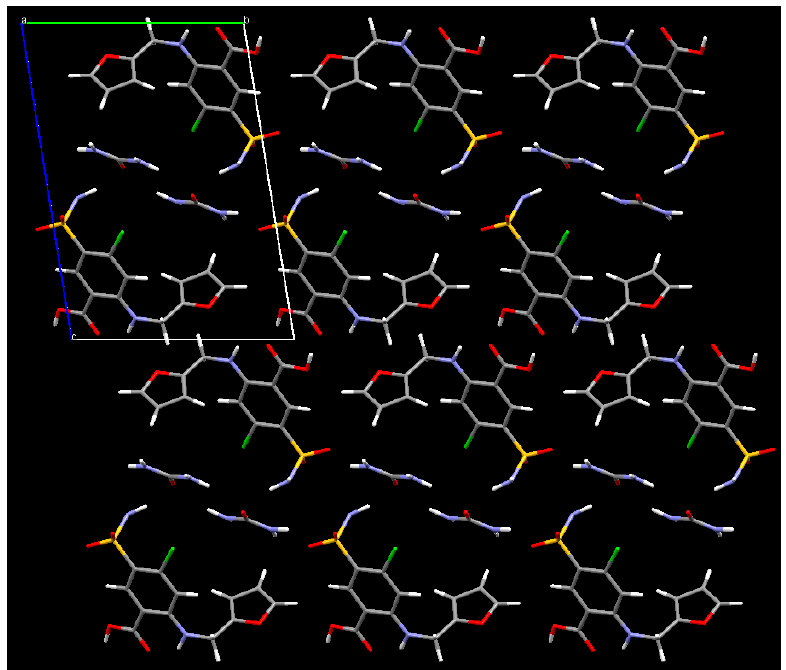
Figure 2. The crystal structure of FUR:URE, viewed down the a -axis. The contents of three unit cells along b and two unit cells along c are displayed, showing the layering of the urea molecules between the furosemide molecules.